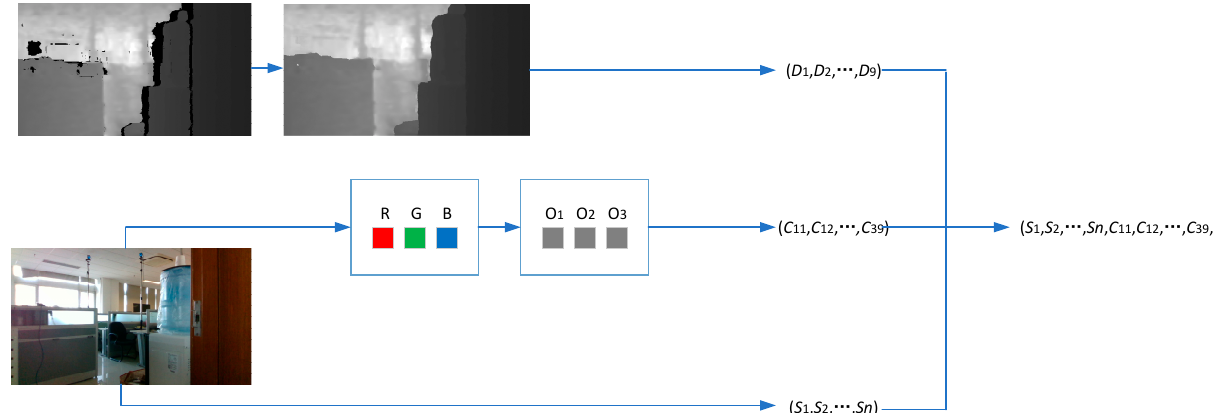
Figure 2. Improved VLAD coding framework.